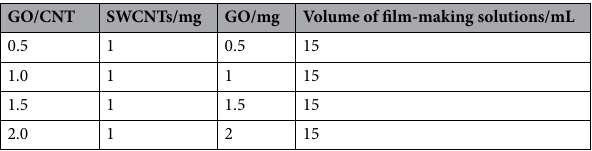
Table 1. Formula of film-making solutions.